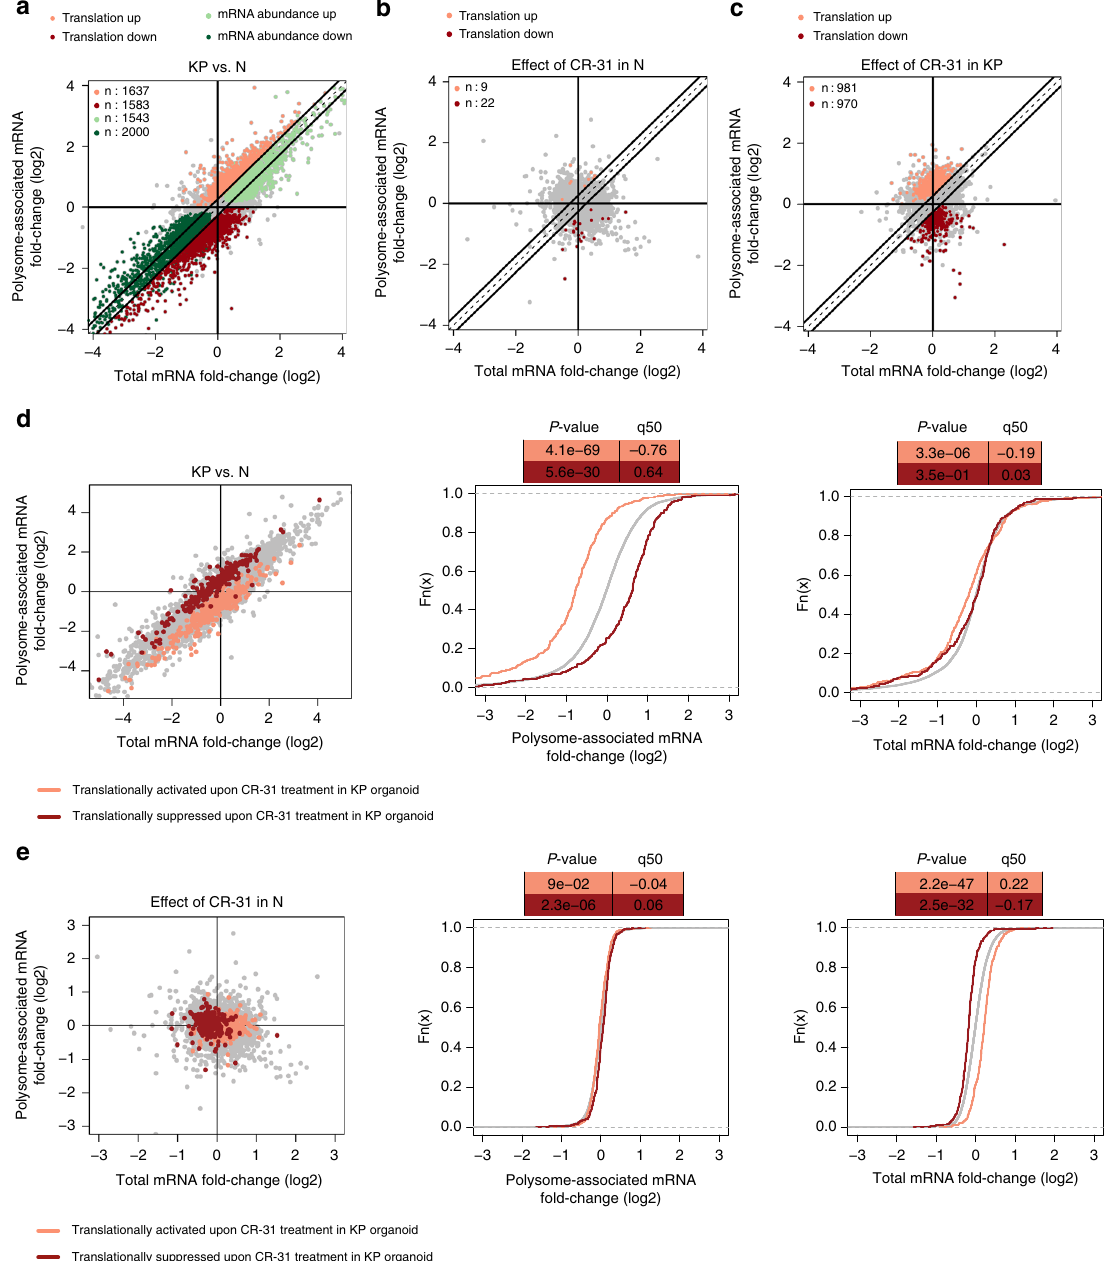
Translationally activated upon CR-31 treatment in KP organoid Translationally suppressed upon CR-31 treatment in KP organoid Fig. 2 Tumour-selective modulation of translational ef fi ciencies by CR-31. a Scatterplot of polysome-associated mRNA to total mRNA log2 fold-changes comparing vehicle-treated Kras G12D ;p53 R172H (KP) to normal (N) organoids. The numbers of mRNAs with a change in translation ef fi ciency (light red and dark red) or mRNA abundance (light green and dark green) are indicated ( n = 3; positive log2 fold-change indicates higher translation/abundance in KP organoids). b Scatterplot of polysome-associated mRNA to total mRNA log2 fold-changes comparing N organoids treated with vehicle or 10 nM CR-31 for 1 h. The numbers of mRNAs with a change in translation ef fi ciency (light red and dark red) are indicated (negative log2 fold-change indicates suppressed translation upon CR-31 treatment). c Scatterplot of polysome-associated mRNA to total mRNA log2 fold-changes comparing KP organoids treated with vehicle or 10 nM CR-31 for 1 h. The numbers of mRNAs with a change in translation ef fi ciency (light red and dark red) are indicated (negative log2 fold- changes indicates suppressed translation upon CR-31 treatment). d Scatterplot of log2 fold-changes for polysome-associated mRNA and total mRNA (left), an empirical cumulative distribution (ecdf) of log2 fold-changes for polysome-associated mRNA (middle) and total mRNA (right) comparing KP and N organoids. Transcripts whose translation was activated (light red) or suppressed (dark red) upon CR-31 treatment in KP organoids (i.e. from ( c )) are indicated for each plot. Wilcoxon rank-sum test p-values comparing regulation of subsets to background are indicated together with the log2 fold-changes difference between these subsets to the background at the 50th percentile (q50) of the ecdf. e Same representation as in panel d but examining differences in gene expression in N organoids upon CR-31 treatment. Source data are provided as a Source Data fi